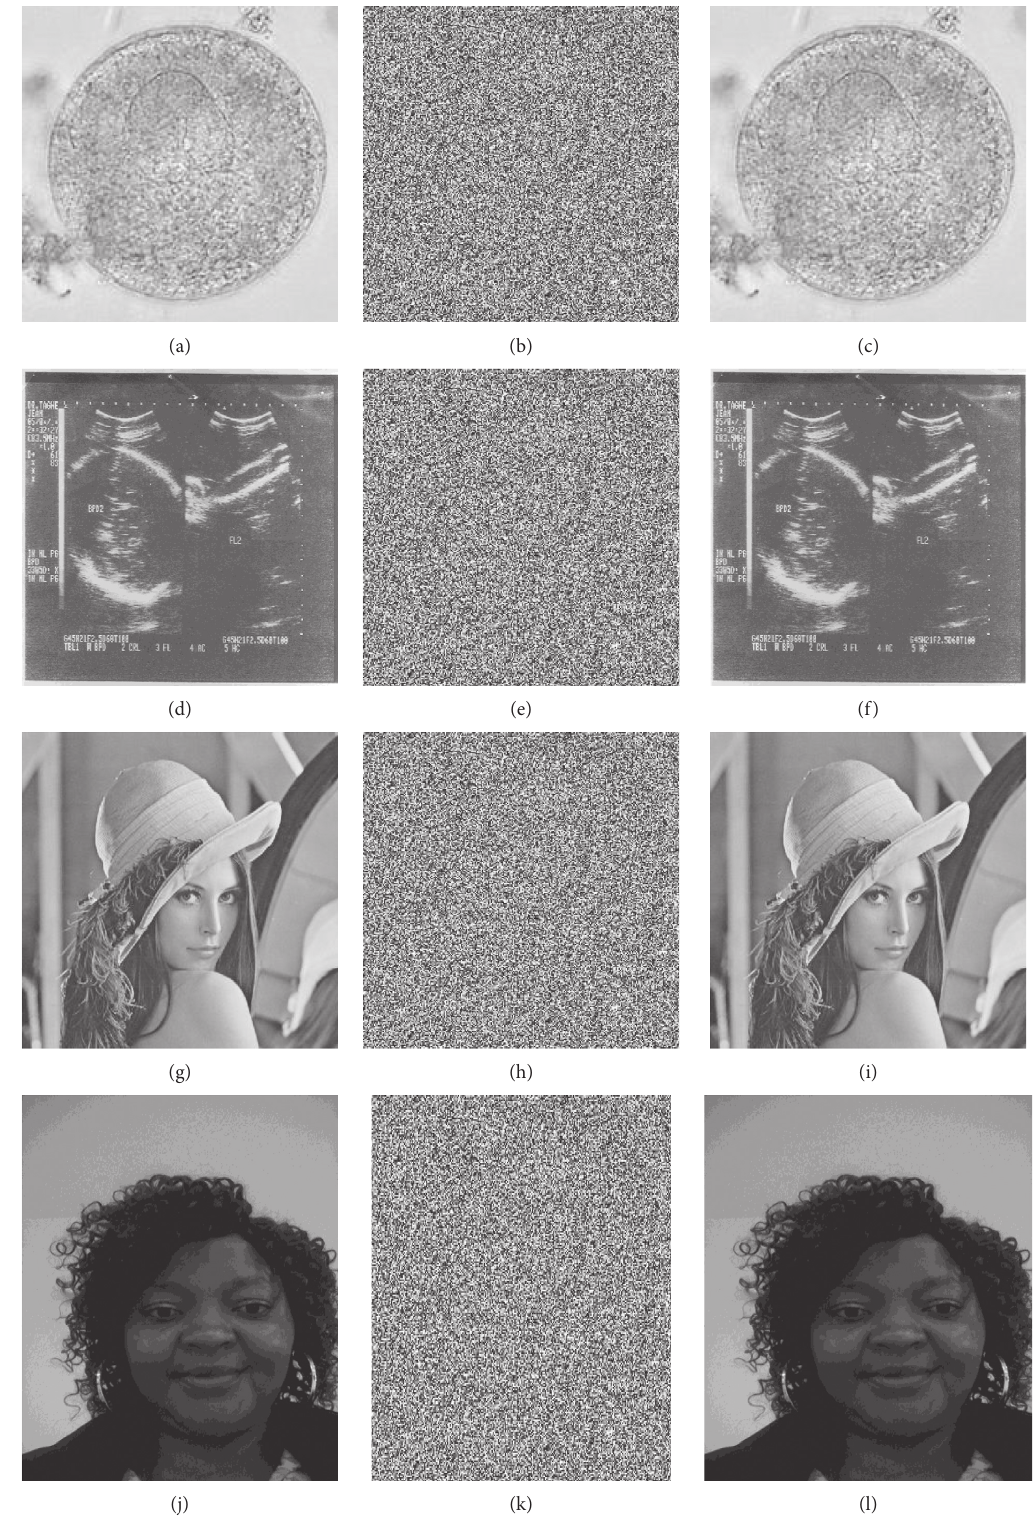
Figure 4: Visual test on some images using the secret key «A23C56789ABADEF7167DEAB6789367A9»: (a), (b), and (c) A plain image “Balantidum Coli cyst” and its corresponding cipher and decrypted image, respectively. (d), (e), and (f) A plain image “echopelv” and its corresponding cipher and decrypted image, respectively. (g), (h), and (i) A plain image “Girl (Lena, 4.2.04)” and its corresponding cipher and decrypted image, respectively. (j), (k), and (l) A plain image “Guefack” and its corresponding cipher and decrypted image,